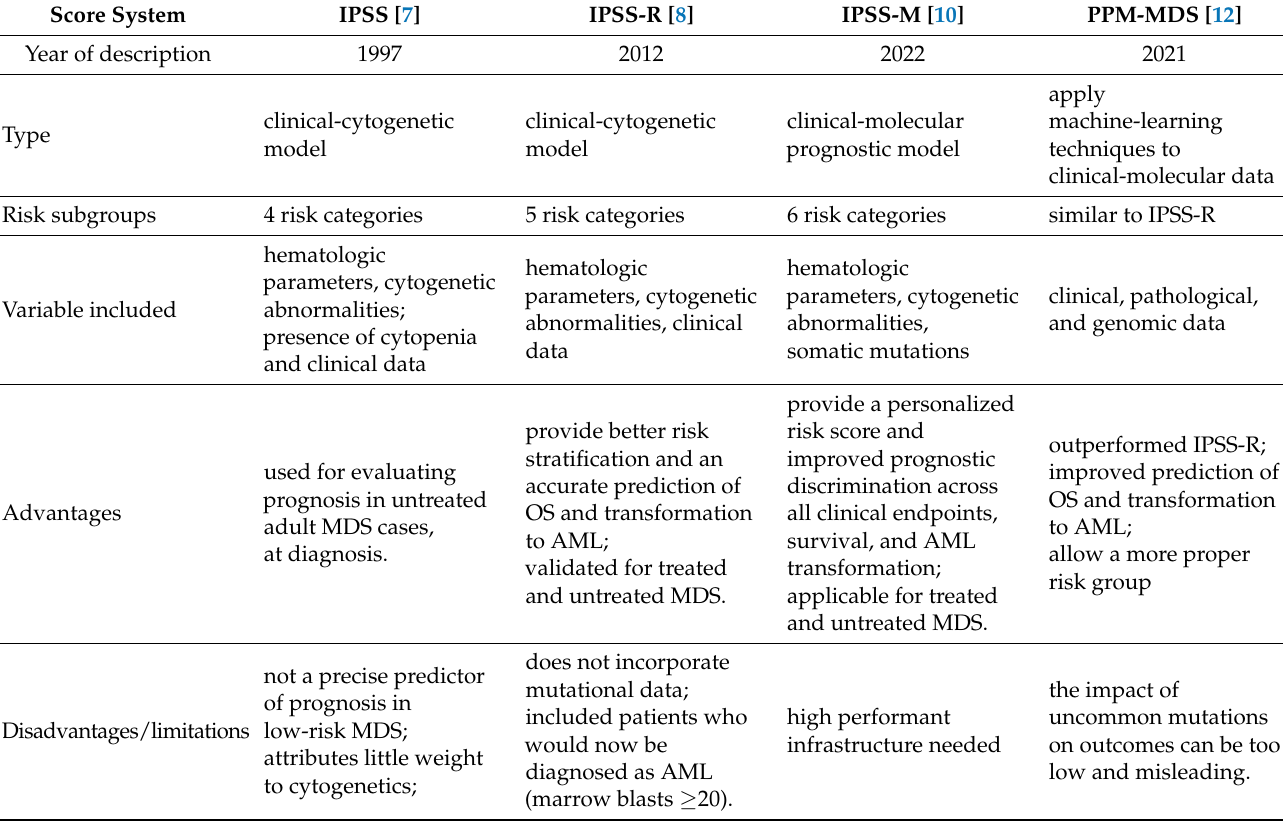
Table 1. Characteristics of different prognostic scoring systems in